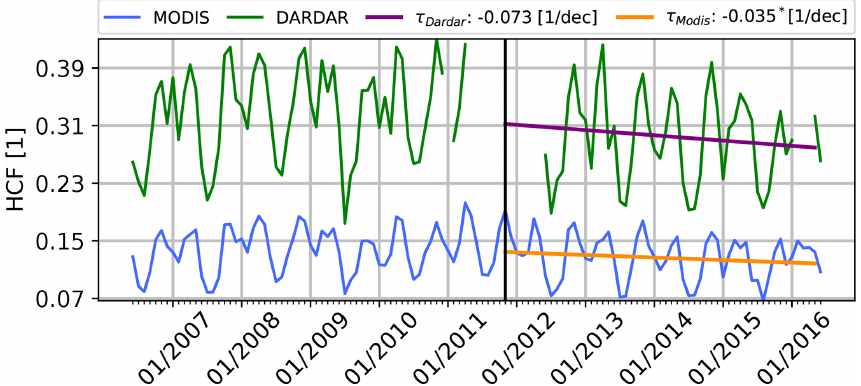
Figure 5. Comparison of the tropical Atlantic domain average of the 2 ◦ × 2 ◦ DARDAR (green) and MODIS (blue) HCF monthly means.